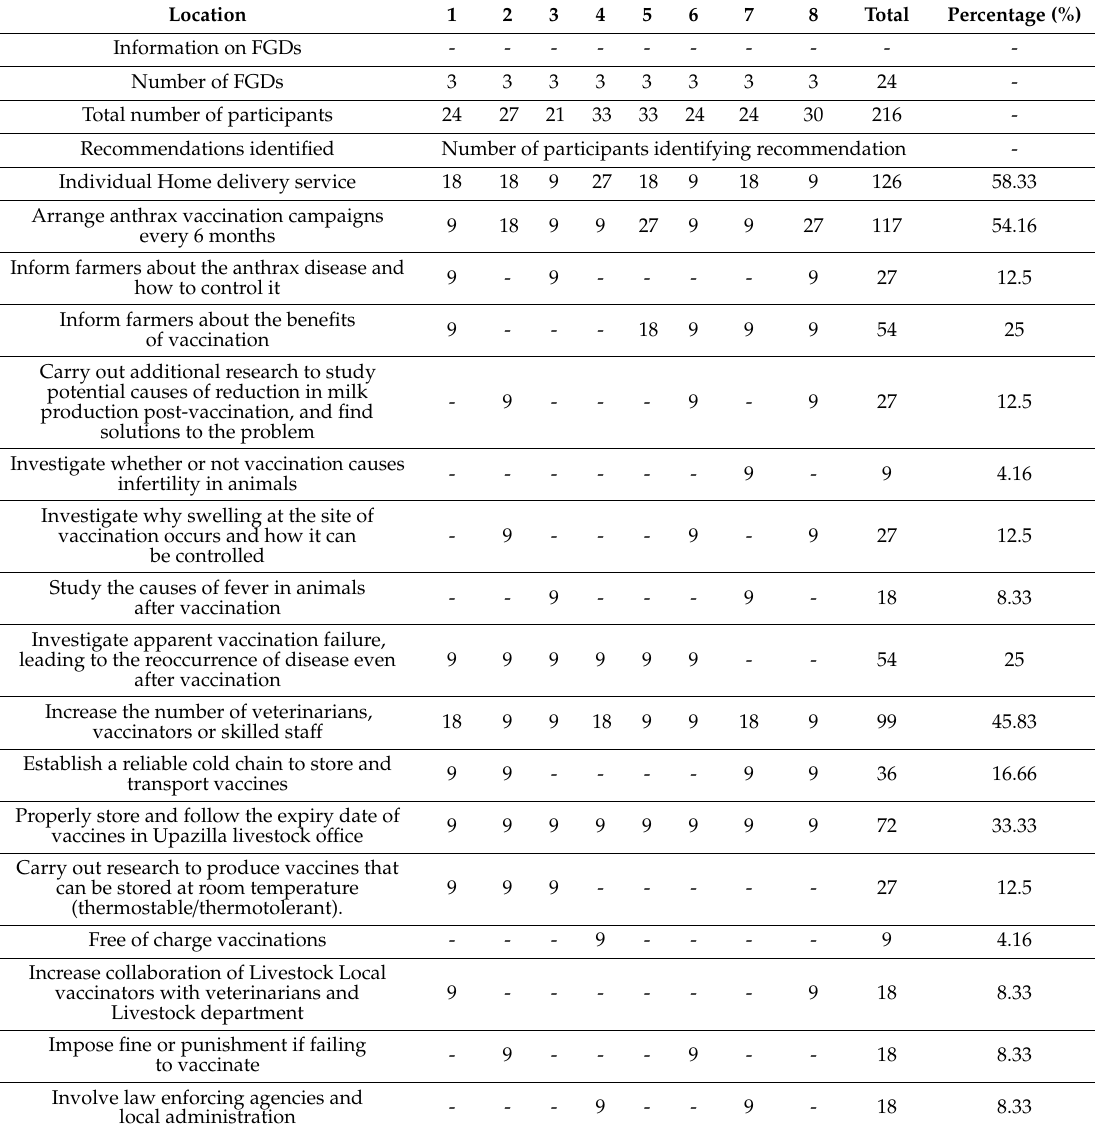
Table 2. Key recommendations for maximizing anthrax vaccine uptake form the Focus Group Discussions in the present